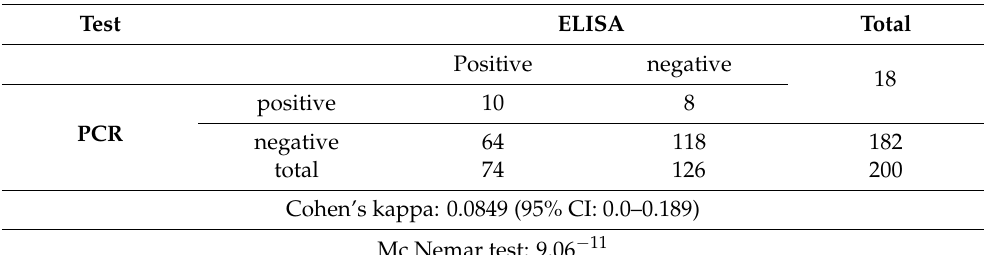
Table 1. Agreement between the results of the analysis of bovine bulk milk tank (BMT) positive samples by means of two diagnostic methods (ELISA and PCR) for C. burnetii